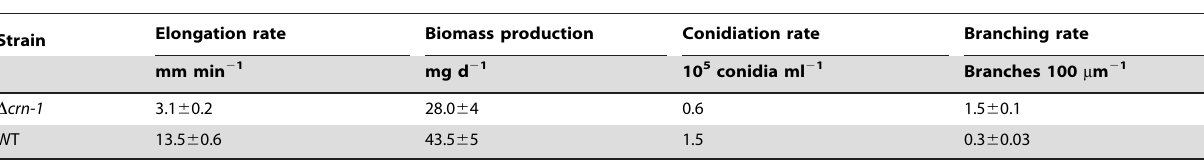
Table 1. Growth kinetics, conidiation rate and branching.